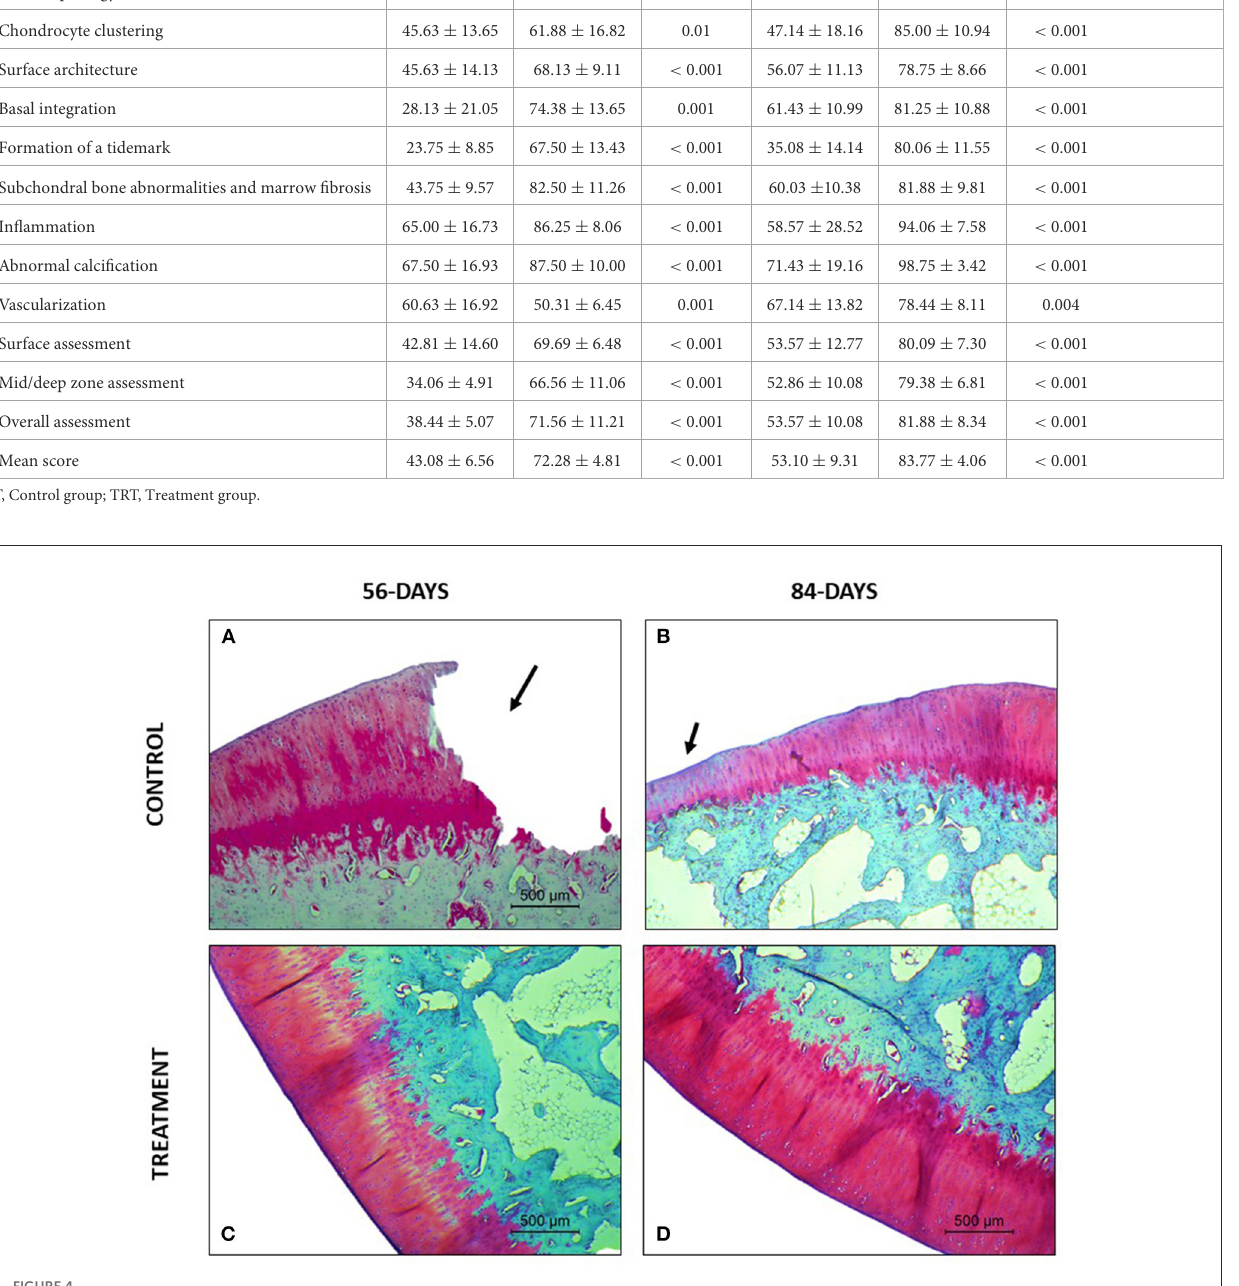
FIGURE4 Safranin O- Fast green stained sections. (A) Complete loss of superficial, mid and deep zones of the articular cartilage. (B) Loss of articular cartilage thickness in the defect area. Loss of safranin-o staining indicating a loss of proteoglycans. (C) Good proteoglycan distribution with some areas with loss of staining. (D) Full extracellular matrix